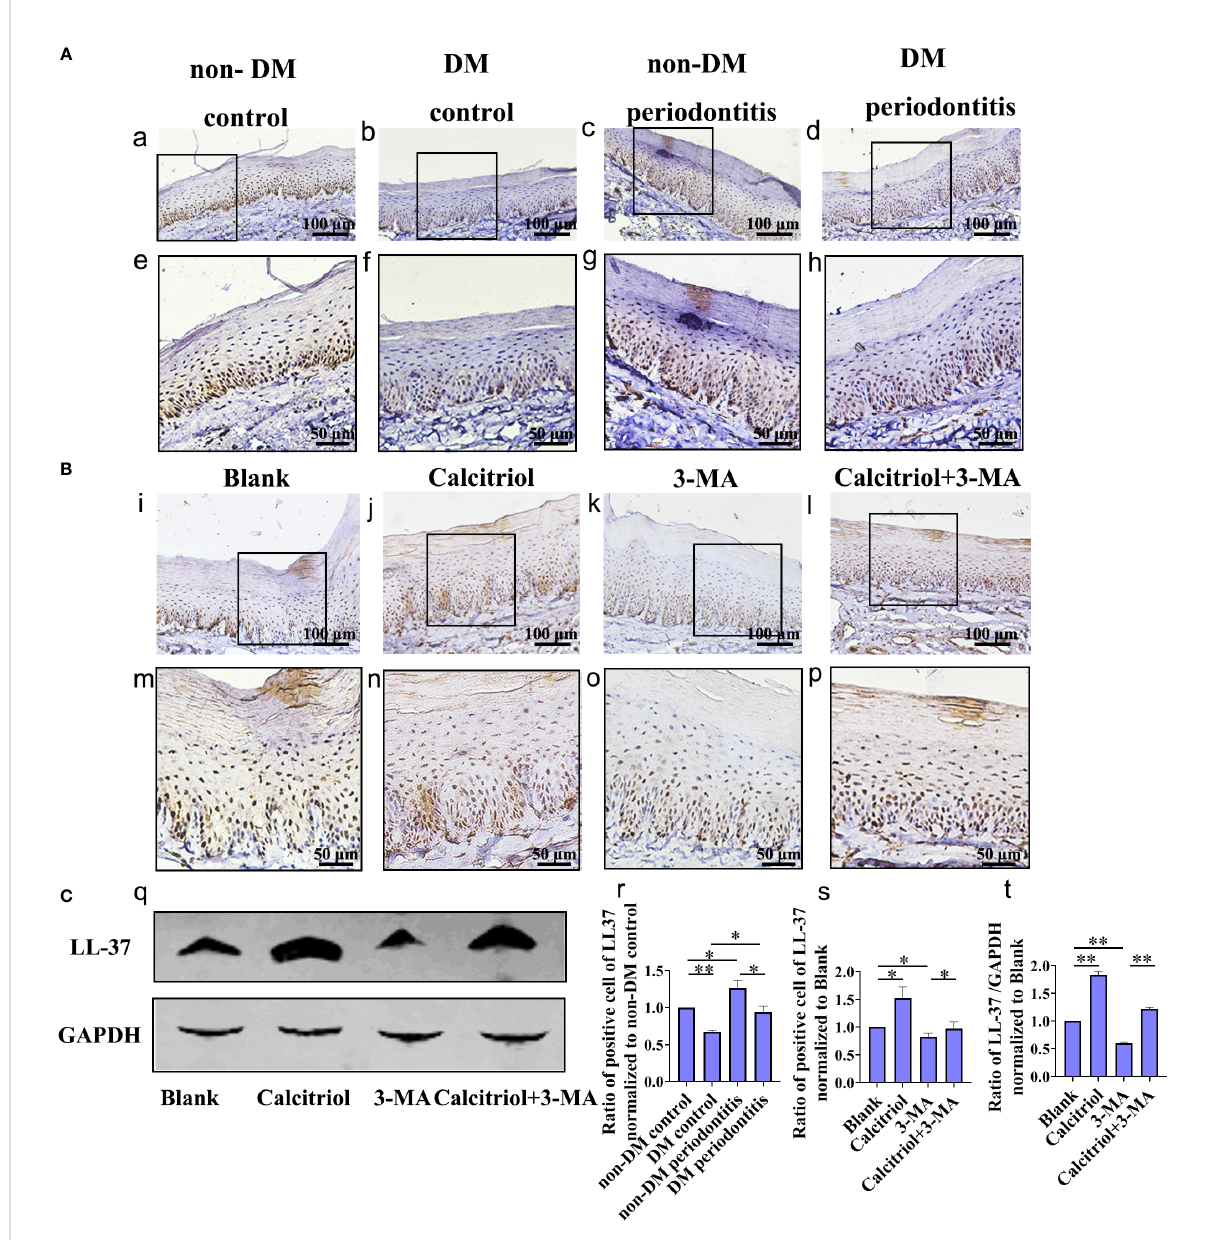
FIGURE 6 Decrease of LL-37 in the gingival epithelial cells of T2DM rats, which was rescued by calcitriol treatment. (A) IHC staining of the gingival epithelium obtained individually from the non-DM control group, non-DM periodontitis group, DM control group and the DM periodontitis group (a-h, r). Non-DM control group, health control without type 2 diabetes mellitus (T2DM) and periodontitis; non-DM periodontitis group, ligation/ P. gingivalis- induced periodontitis but without T2DM; DM control group, high-fat diet and low dose of streptozotocin-induced T2DM but without periodontitis; DM periodontitis group, combination periodontitis and T2DM. (B) IHC staining of the LL-37 expression in the gingival epithelium of different groups (i-p, s). The diabetic rats with periodontitis were randomly divided into blank group (propylene glycol: water: ethyl glycol=60:30:10), calcitriol group (2 µg/kg), 3-MA group (15 mg/kg) and calcitriol + 3-MA group. (C) Western Blot reveals the expression of LL- 37 in four groups (q) analysis of the LL-37 expression in the gingival epithelium (t). All data are presented as mean ± SD (n = 3) relative to non- DM and blank group are shown in bar graphs (* P <0.05, ** P <0.01, compared with the blank